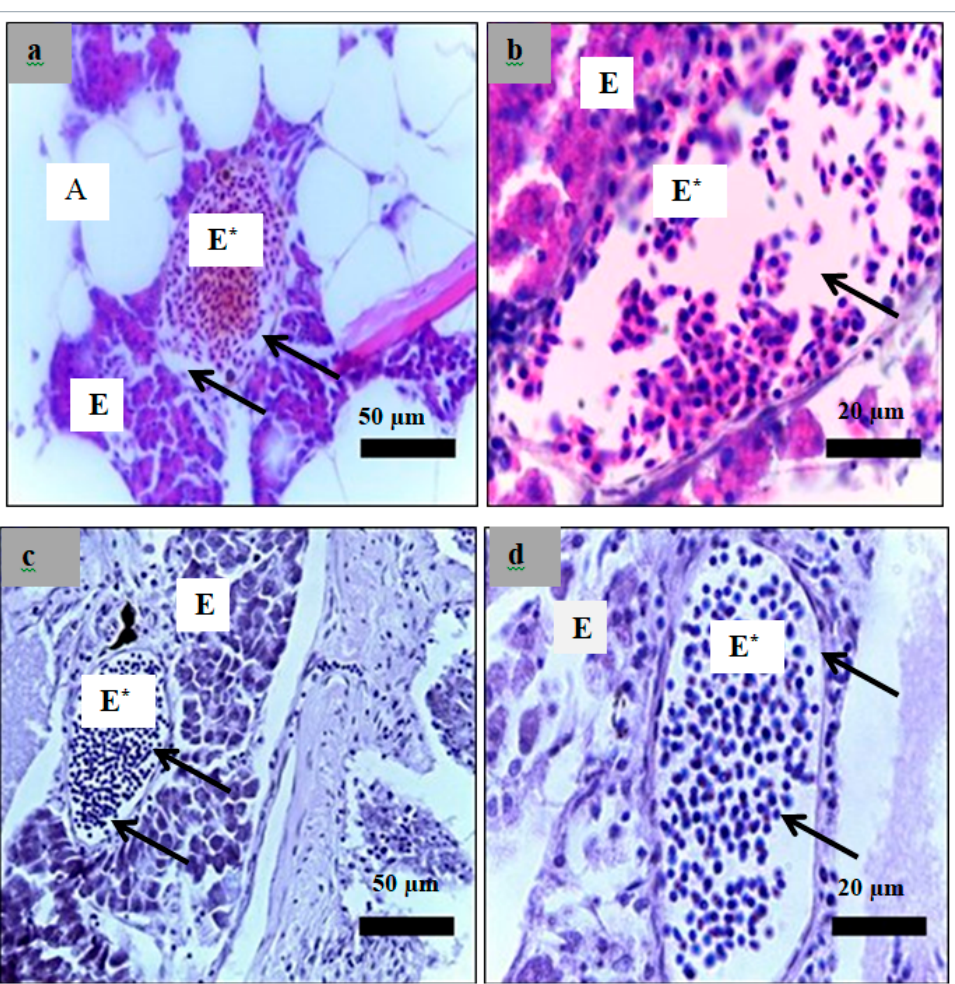
Figure 12. Paraffin section of islet of zebrafish pancreas analyzed using hematoxylin and eosin. ( a ): The insulin-treated zebrafish (40 × magnification); ( b ): The insulin-treated zebrafish (100 × magnification); ( c ): The plant extract (dose = 3 g / kg) treated zebrafish (40 × magnification); ( d ): The plant extract (dose = 3 g / kg) treated zebrafish (100 × magnification); The islets showed a high reduction of endocrine islets cellularity as indicated by the arrows. E*: endocrine part, E: exocrine part. A: adipose tissue.